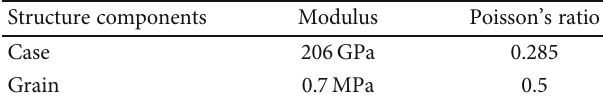
Table 1: Property parameters of the case and the